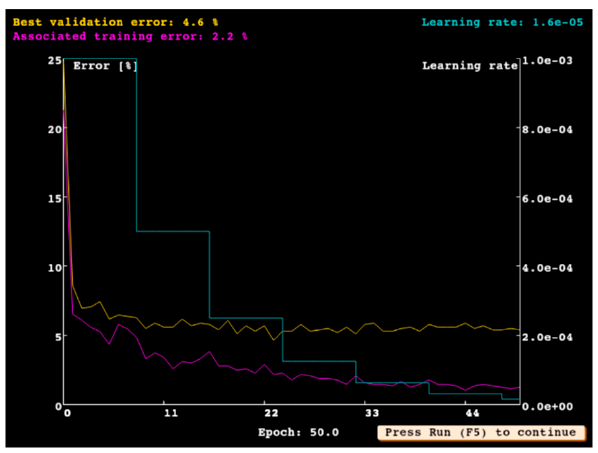
Figure 9. Training curve of the final classification model.